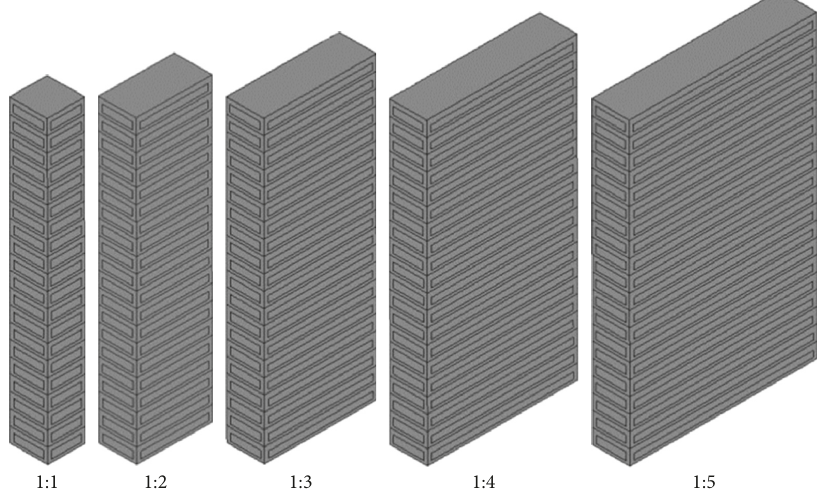
Figure 3: Energy model for ratio of long side to short side analysis using BIM.